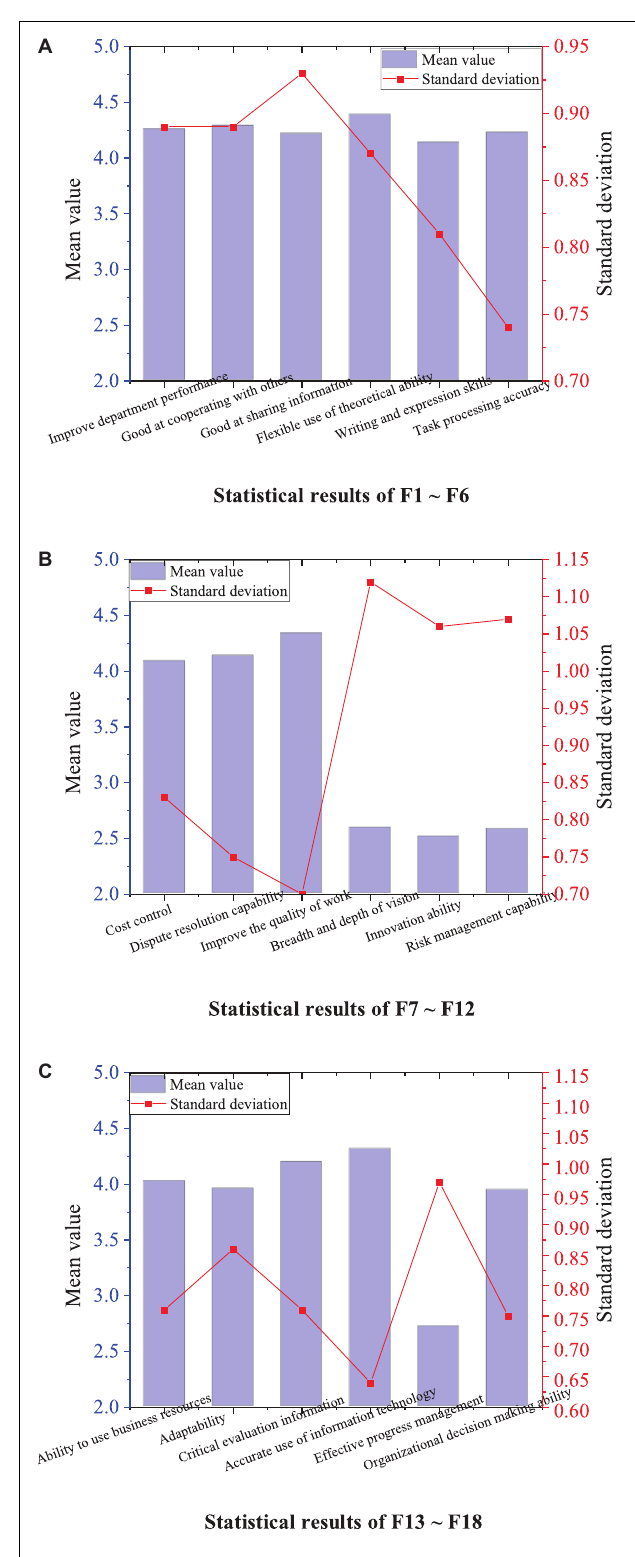
FIGURE 3 | Mean and standard deviation statistics of 18 indexes. (A) Statistical results of F1–F6. (B) Statistical results of F7–F12. (C) Statistical results of